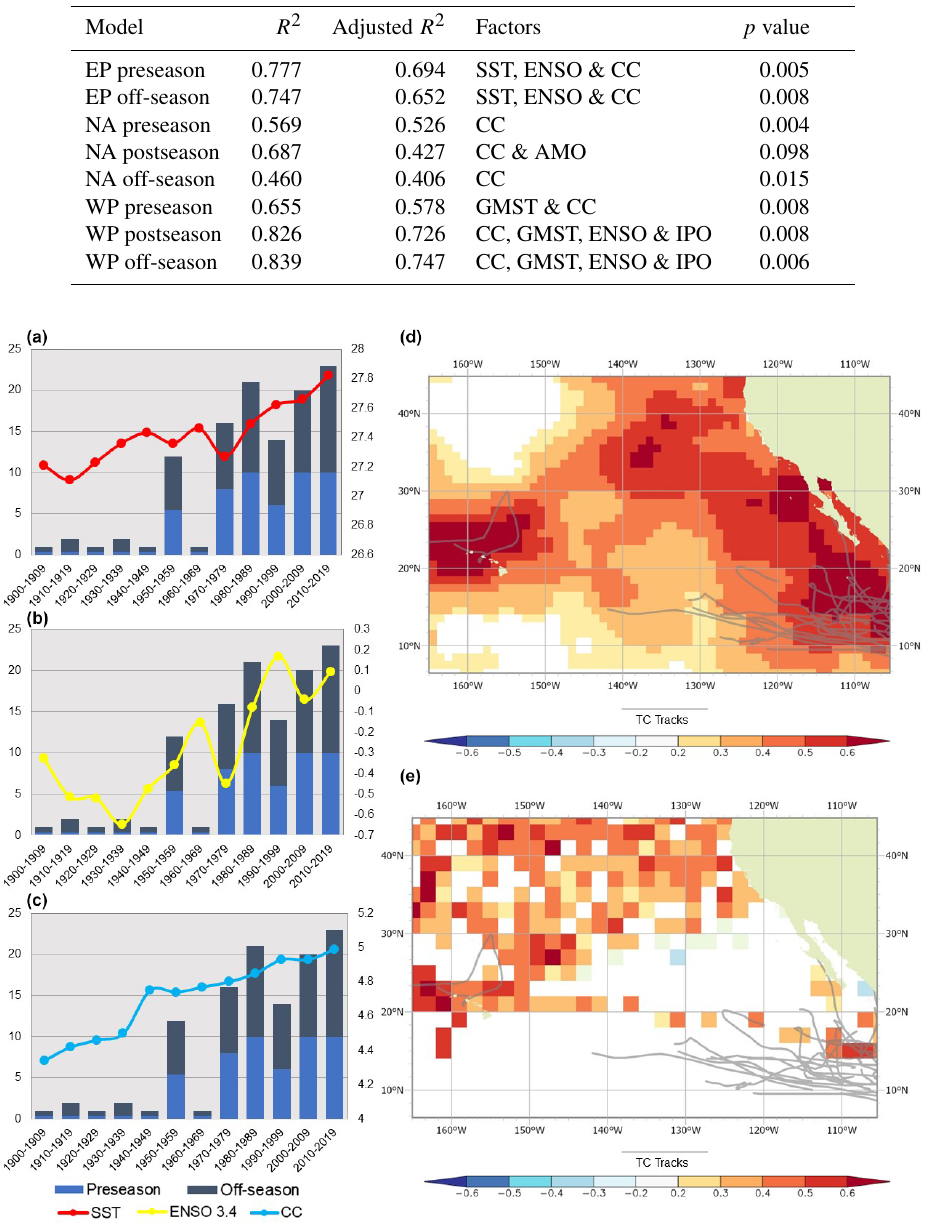
Table 4. Stepwise multiple linear regression (MLR) models for basins with statistically significant increasing trends in off-season TCs.